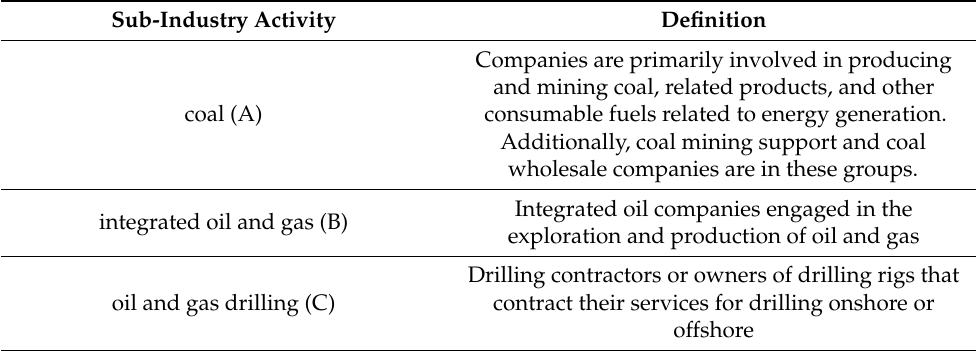
Table 2. Sub-industry classification, according to TRBC (The Refinitiv Business